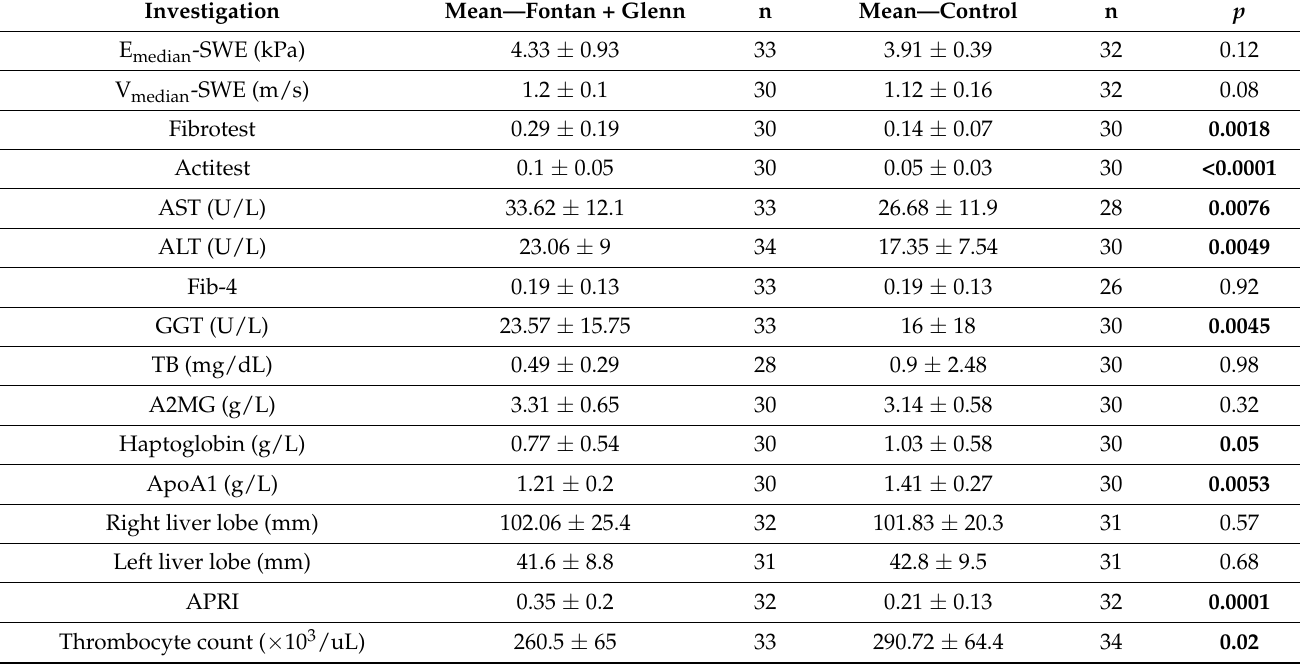
Table 3. Operated patients (Fontan + Glenn) vs. controls—elastography and biomarker